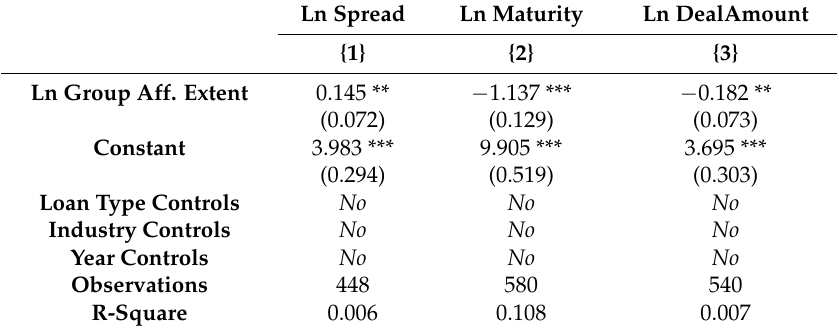
Table 3. OLS regressions of Cost of Loans on Group Affiliation Extent without any control variables. Table 3 presents the pooled ordinary least squares (OLS) regression results of ln (Maturity), ln (Spread), and ln (DealAmount) on Group Affiliation Extent. Group Affiliation Extent is calculated based on the percentage of group ownership in borrower firms (0% indicates that there is no group association, and 100% means that the associated group owns all the firm’s shares). No control variables are included. Robust standard errors are reported in parentheses. Each model is clustered at the group level to control for possible group fixed effects. *, **, and *** represent significance levels of 10%, 5%, and 1% respectively. Ln